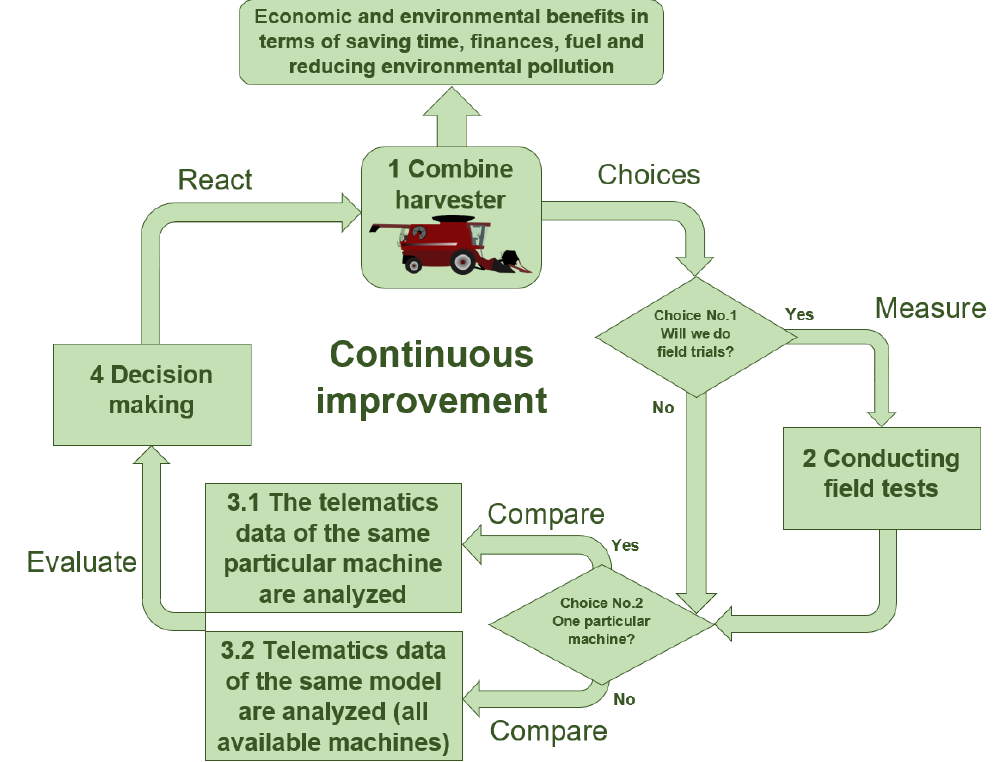
Figure 5. Dual telematics/field test data analysis method process to reduce fuel consumption and environmental pollution.